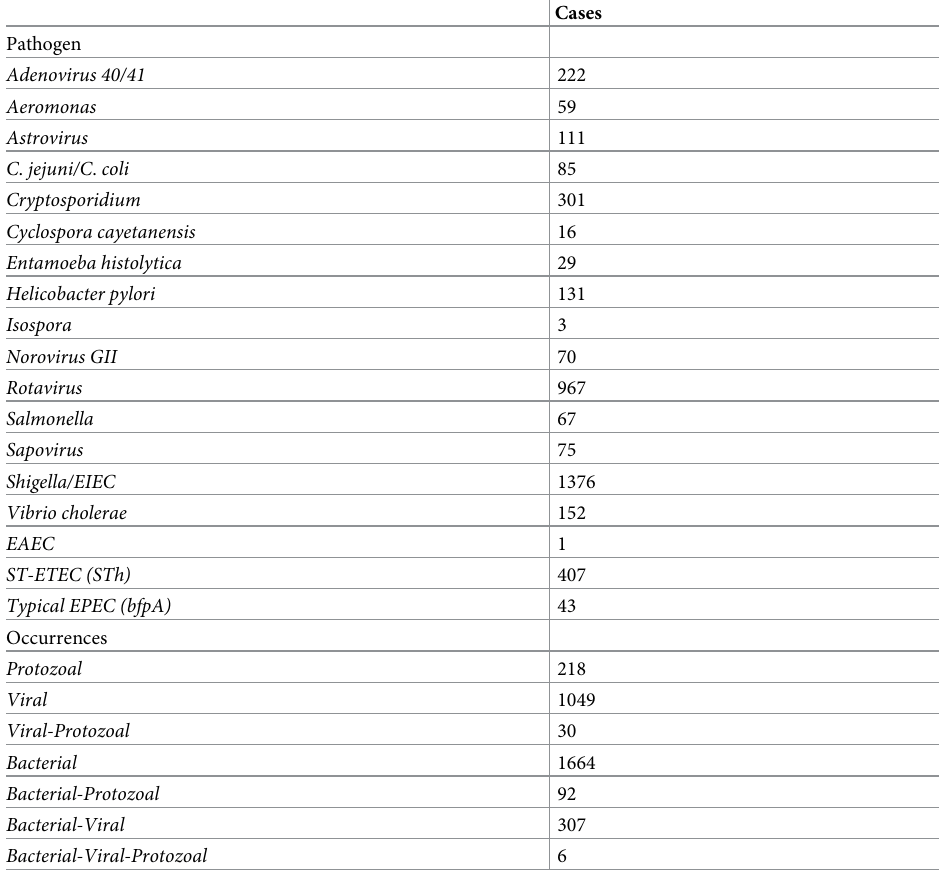
Table 1. Number of cases attributed to each pathogen with an attributable fraction above 0.5.